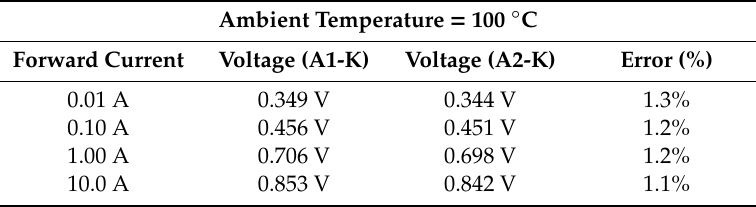
Table 2. Uniformity of current-voltage characteristics of twin diodes at 100 ◦ C.